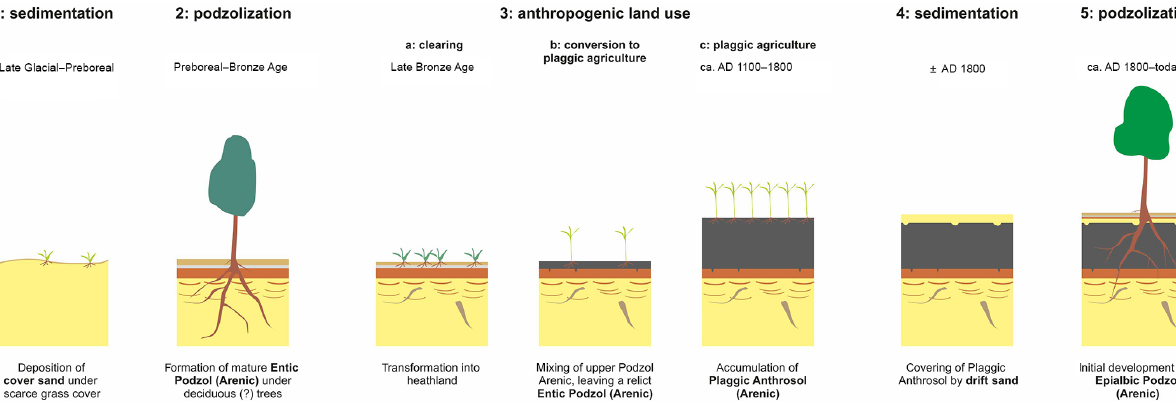
Figure 9. Schematic figure of the successive phases of sedimentation and soil formation that led to the development of the investigated